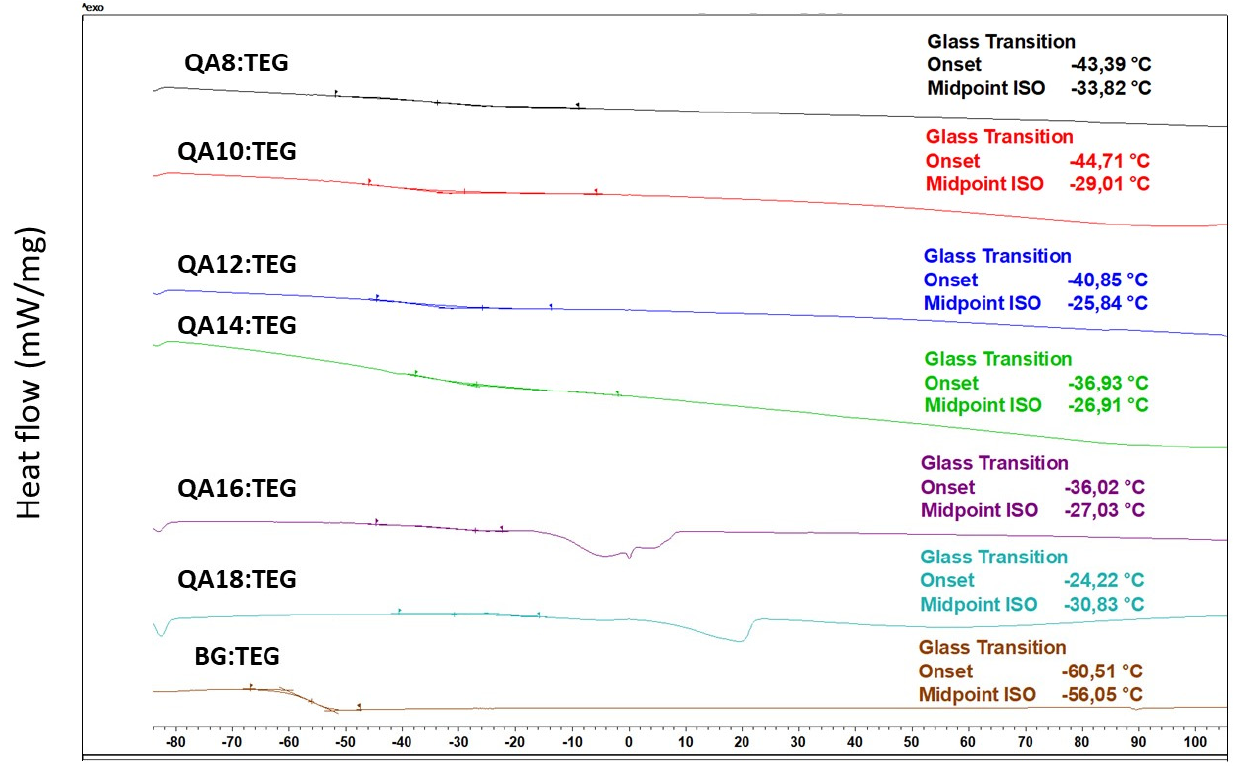
Figure 2. DSC thermograms of the liquid monomer compositions showing their glass transition temperatures.